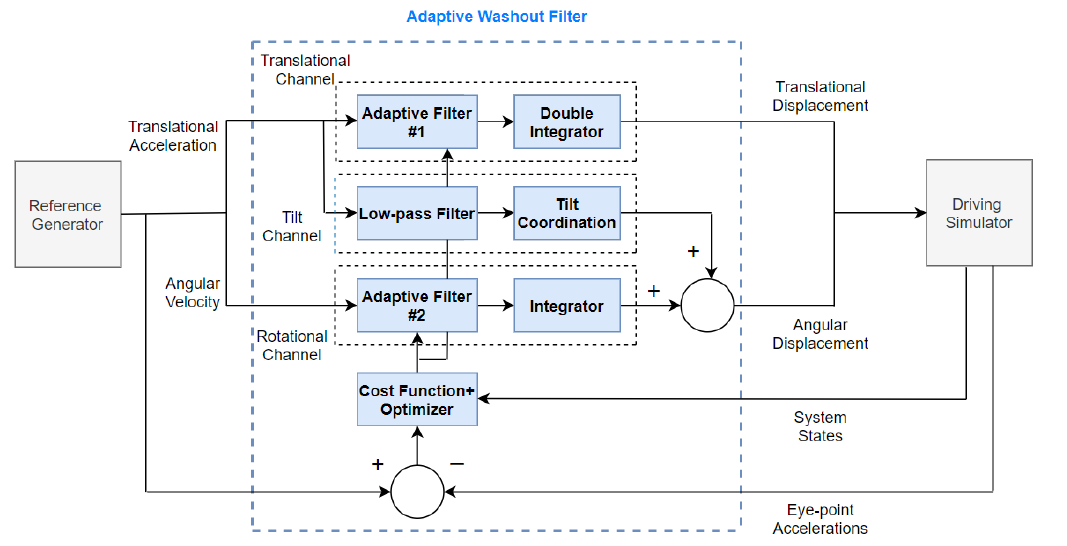
Figure 2. Scheme of adaptive washout filter-based MCA.